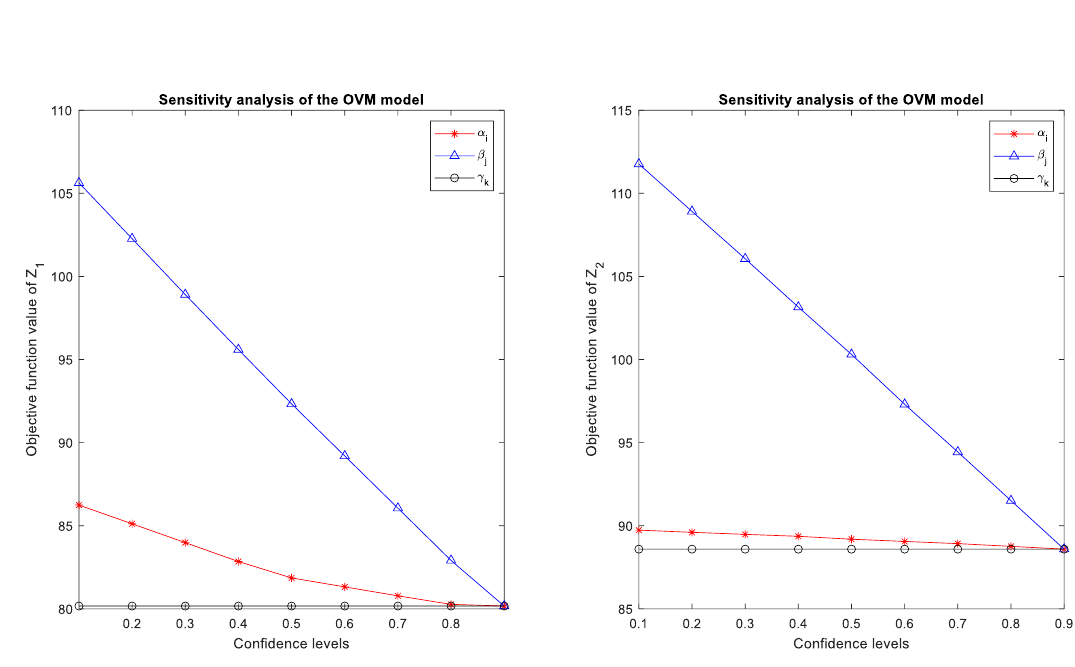
 using FPT.   , and k ji